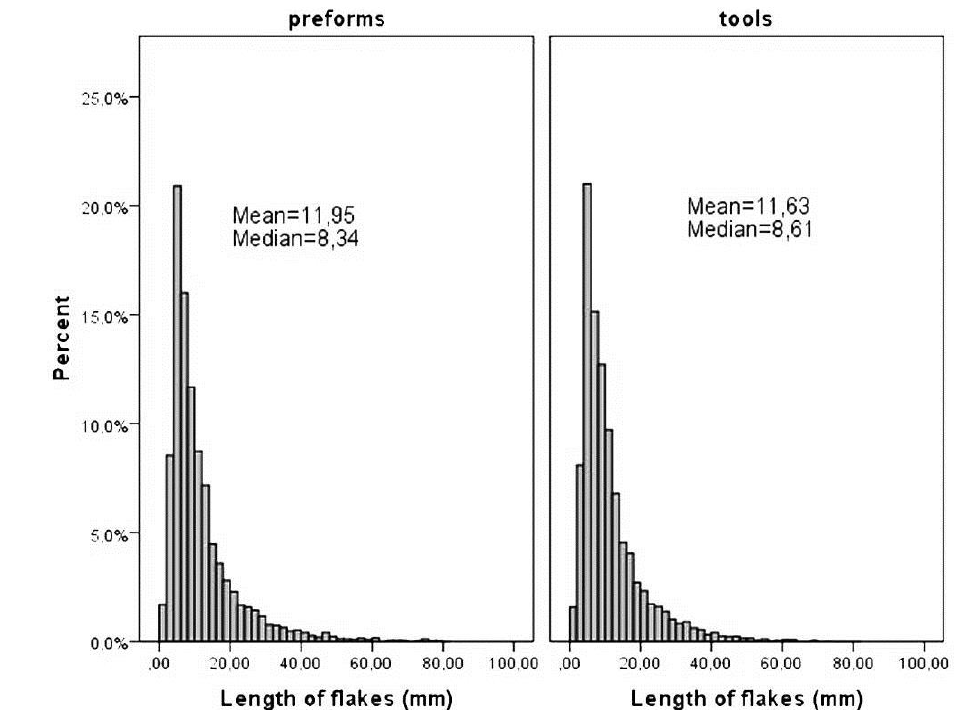
Figure 9. Comparison of flake length distributions in “successful” (resulting in a complete tool) and “failed” experiments. P-value of two-sample K-S test is 0,250